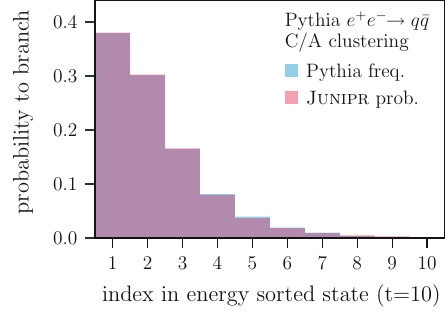
didate’s index in the energy ordered intermediate state. (Right) P mother averaged over all t ’s, as a function of a candidate’s angle relative to the jet